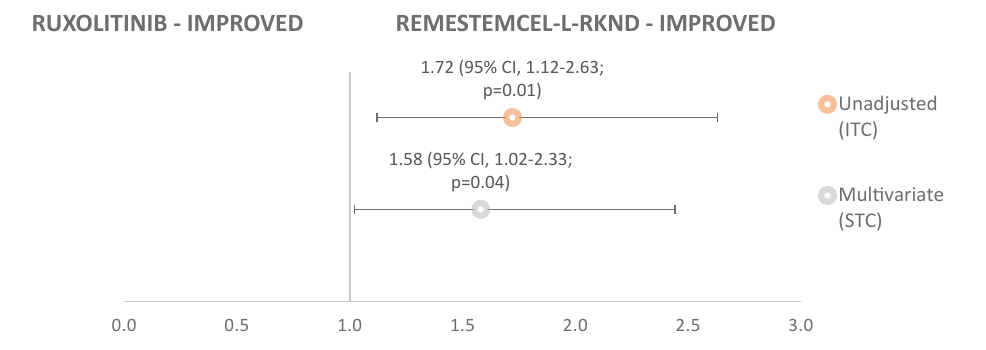
Figure 3. Risk Ratio for 28-day ORR of Remestemcel-L-rknd Versus Ruxolitinib in the Grade III-IV aGVHD Subgroup (N=49 for remestemcel-L-rknd and N=36 for ruxolitinib)